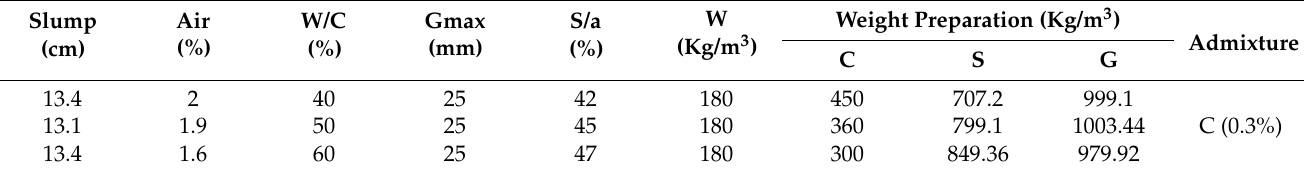
Table 3. Concrete